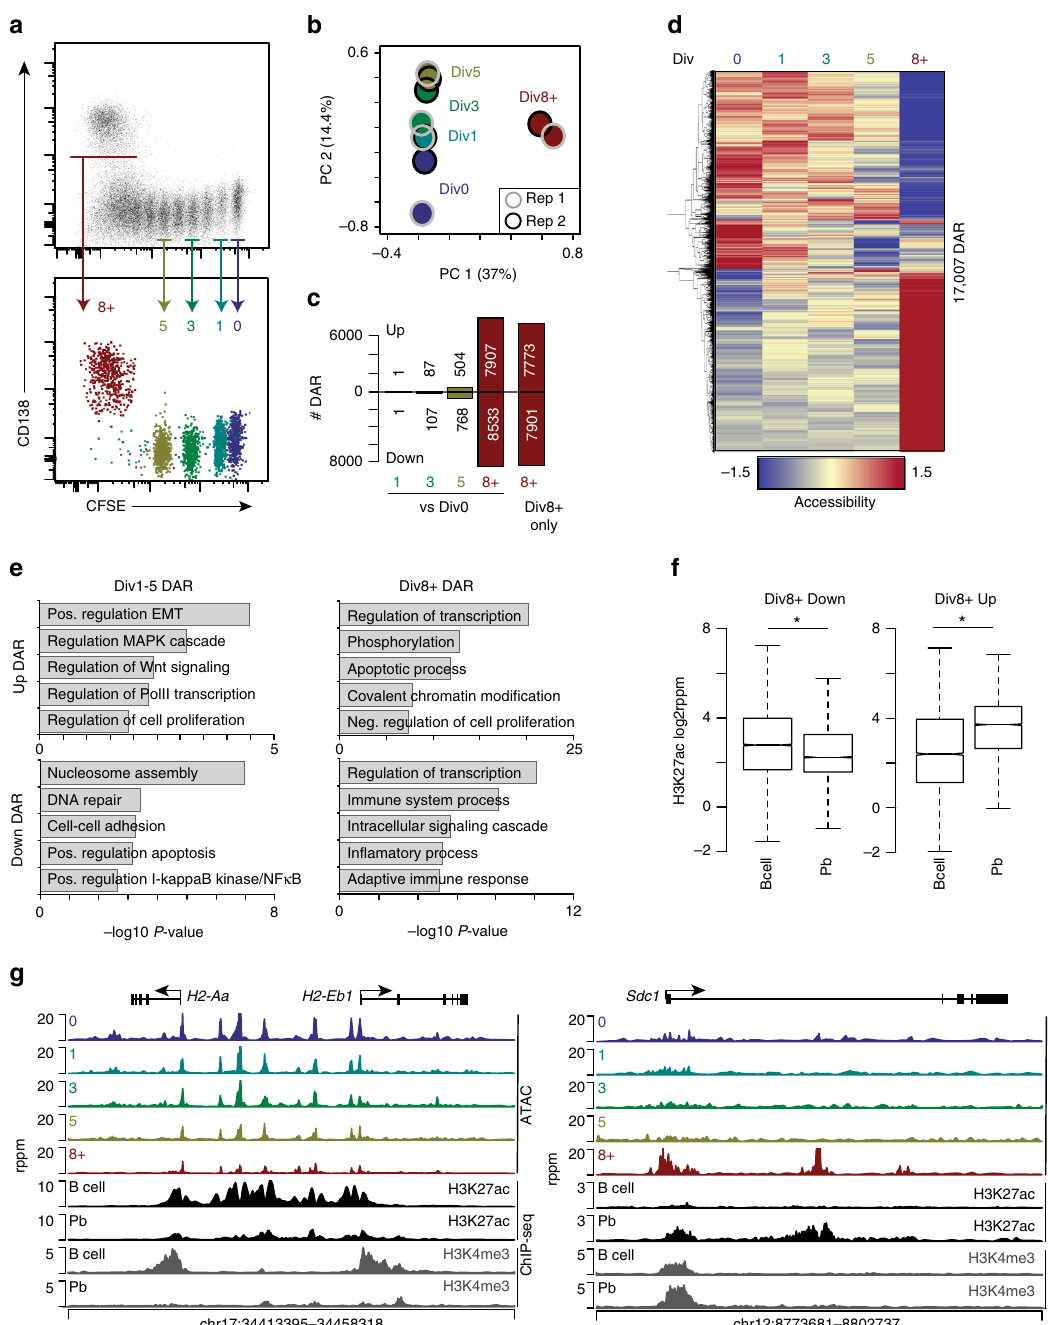
Fig. 1 B cell differentiation is coupled to division-speci fi c changes in chromatin accessibility. a Splenic CD45.1 B cells were labeled with CFSE and transferred to a µ MT (CD45.2) mouse. Twenty-four hours later the mice were inoculated with LPS and splenic B cells were harvested three days post inoculation. Flow cytometry of CD45.1 cells (top) and CSFE sorted populations (bottom) used in this study. b PCA plot of 60,766 accessible loci across all samples. c Bar plot quantifying the number of DAR at each division compared to Div0 B cells that either gained (up) or lost (down) accessibility or those DAR that are speci fi c for Div8 + . d Heat map of ATAC-seq accessibility changes across each division for all signi fi cantly differentially accessible regions (DAR). e Gene ontology analysis of up and down DAR from Div1-5 and Div8 + . f Quanti fi cation of H3K27ac levels at Div8 + up and down DAR in naive B cells (nB) and plasmablasts (Pb). Boxplot center line indicates data median, lower and upper bounds of boxes the 1st and 3rd quartile ranges, and whiskers the upper and lower ranges of the data. * P -value < 2.6e − 16 determined by two-tailed Student ’ s T -test. g ATAC-seq and ChIP-seq pro fi le for the MHCII and Sdc1 gene loci is plotted. ATAC-seq and ChIP-seq data are average of two biological replicates at each division or cell type. PC principal Association of DNA methylation and accessibility changes . divisions and were located within B cell enhancers 2 . To determine During LPS-induced B cell differentiation, approximately 10% of the relationship between DNA methylation and chromatin all CpG change their methylation status, with nearly all losing accessibility, the overlap of DAR and differentially methylated their methylation. Most hypomethylated CpGs occurred at later loci (DML) at Div5 and Div8 + was computed and the correlation